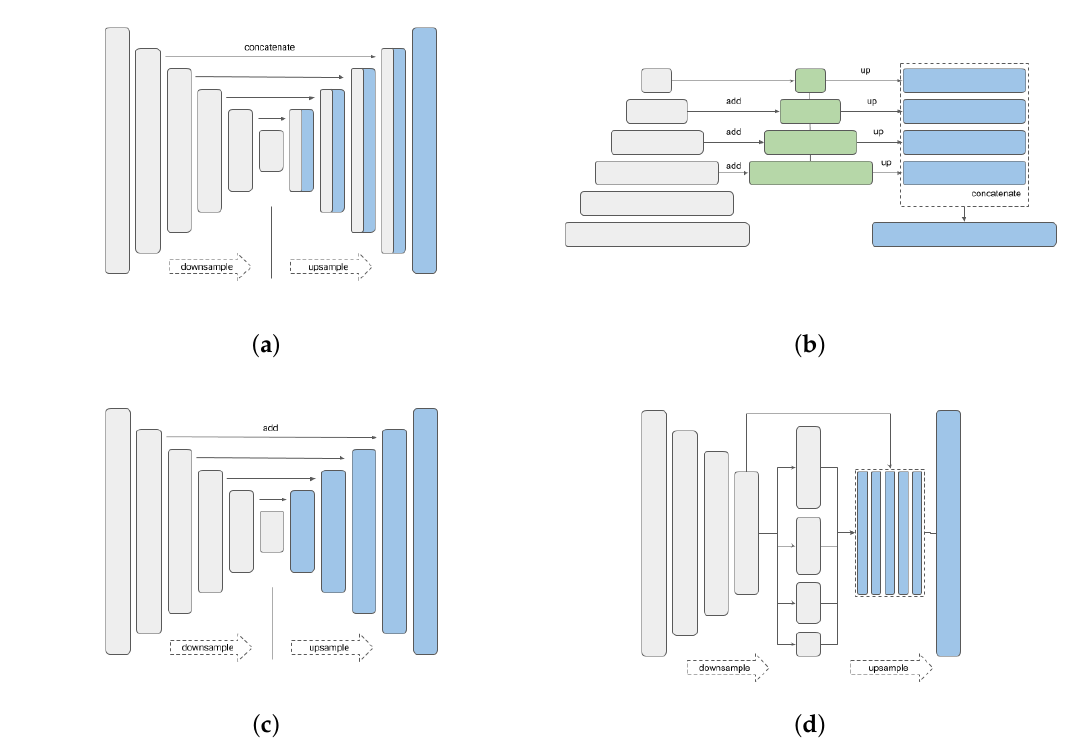
Figure 3. CNN architectures [71]: ( a ) U-Net; ( b ) FPN; ( c ) LinkNet; ( d )